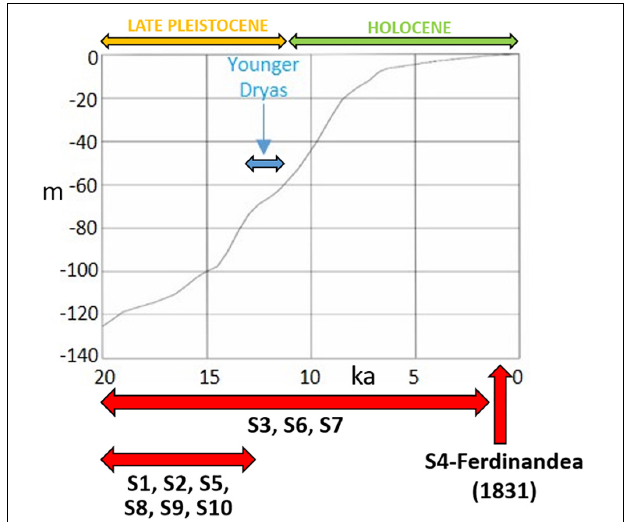
FIGURE 11 | Correlation between mean sea level curve referred to the study area (Lambeck et al., 2011) and proposed possible ages of the volcanism generating the cones of the GVF; see the text for further